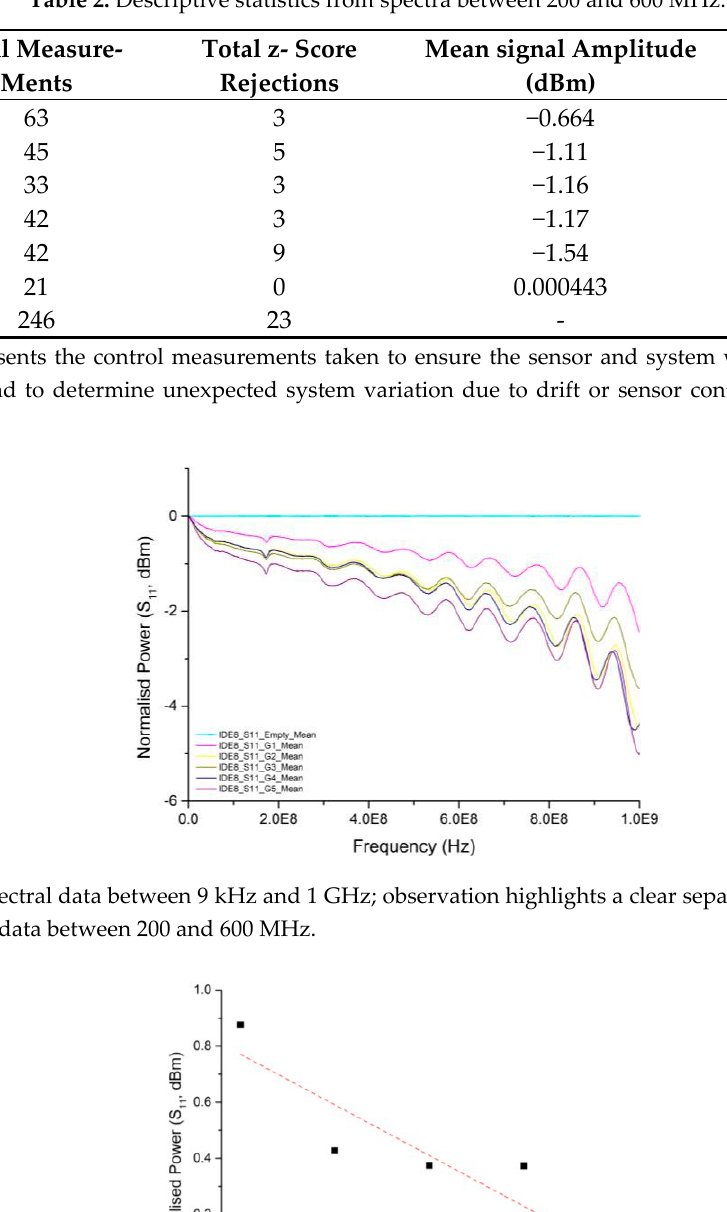
Table 2. Descriptive statistics from spectra between 200 and 600 MHz.